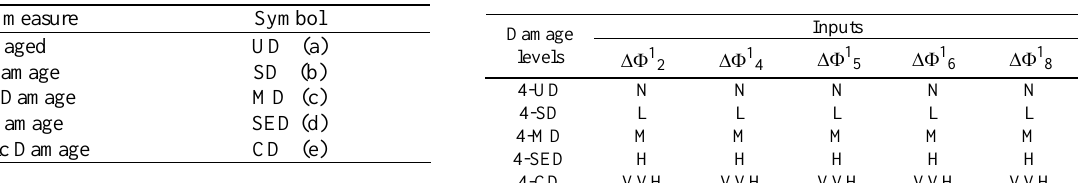
Table 6 Symbols of fuzzy variables of outputs Table 8 Fuzzy rules of case